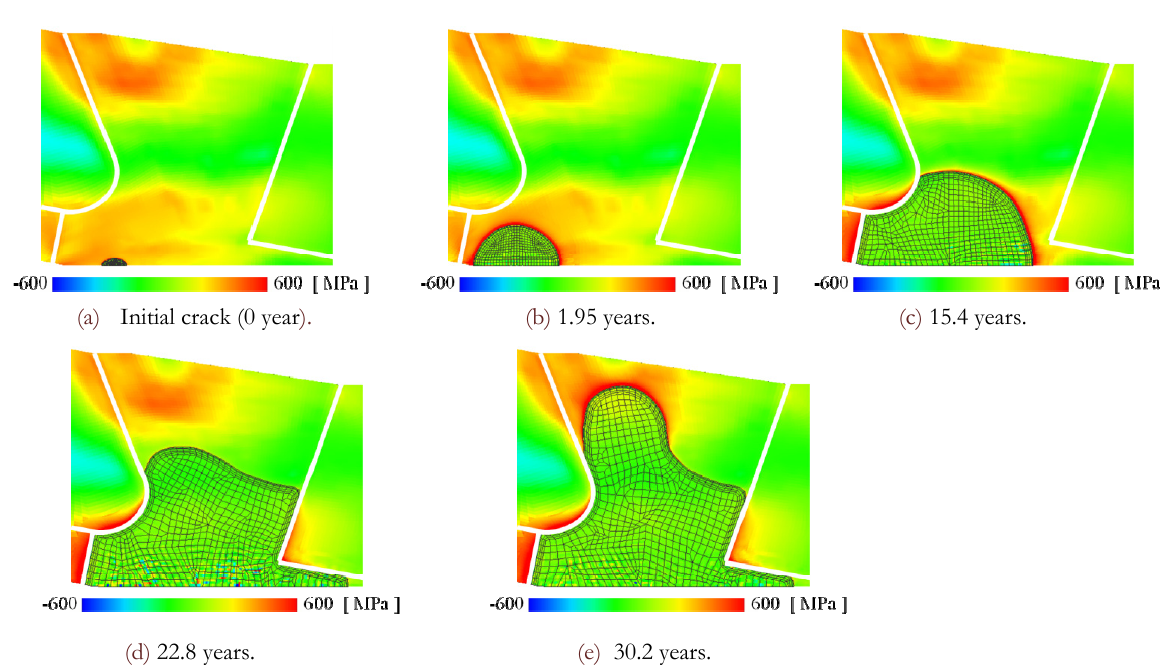
Figure 12: SCC growing process in the hot